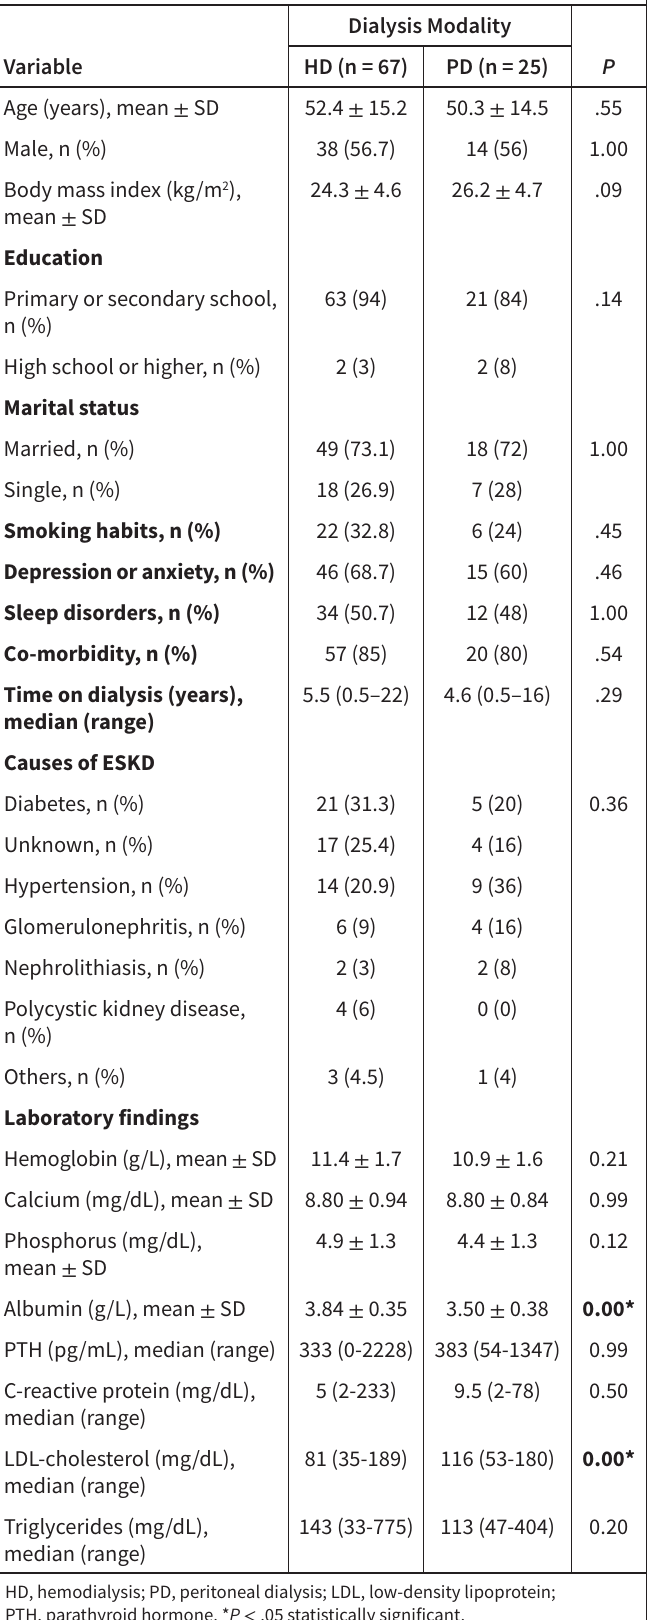
Table 5. Comparison of Temporomandibular Joint Disorders Between Patients Treated with Hemodialysis versus